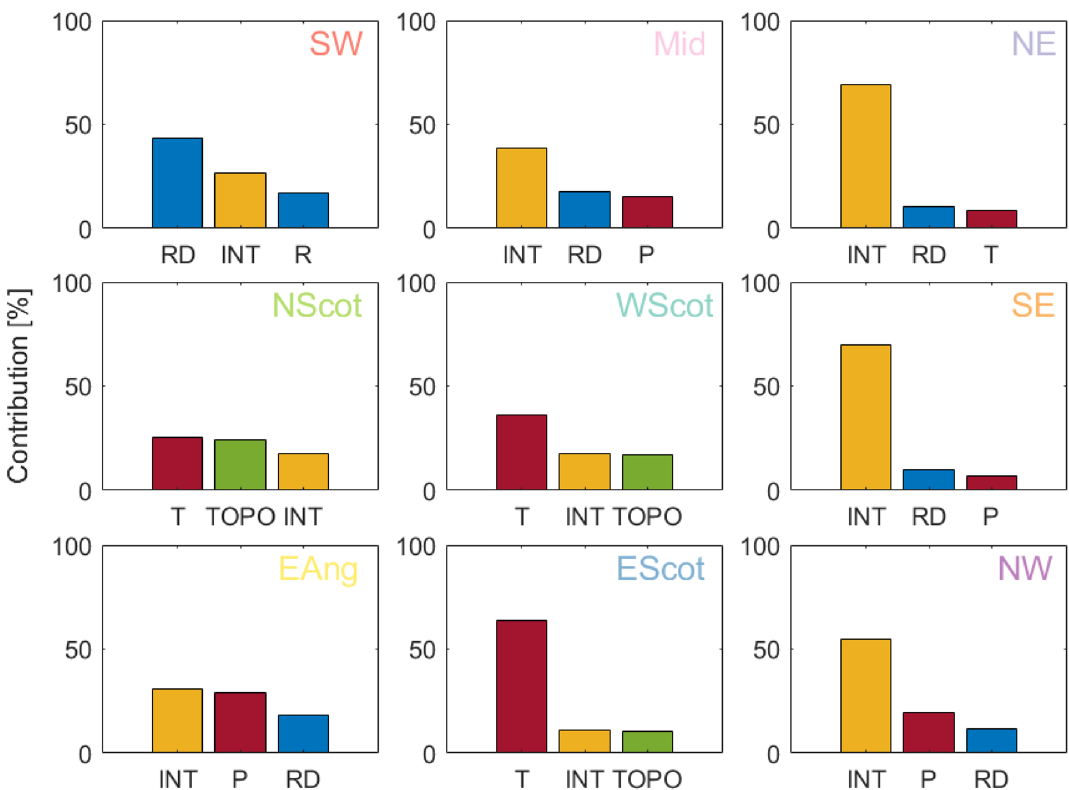
Figure 2. Average percent contribution of the top three environmental drivers to summer disease risk variability simulated using HELF, per region. Rainfall-related characteristics are in blue (RD = number of rainy days and R = rainfall); temperature-related variables are in red (P = potential evapotranspiration and T = temperature); landscape factors are in green (TOPO = topography); and two-way interactions between factors (here combined into a single term INT) are in yellow. Regions are defined in Fig. 1.